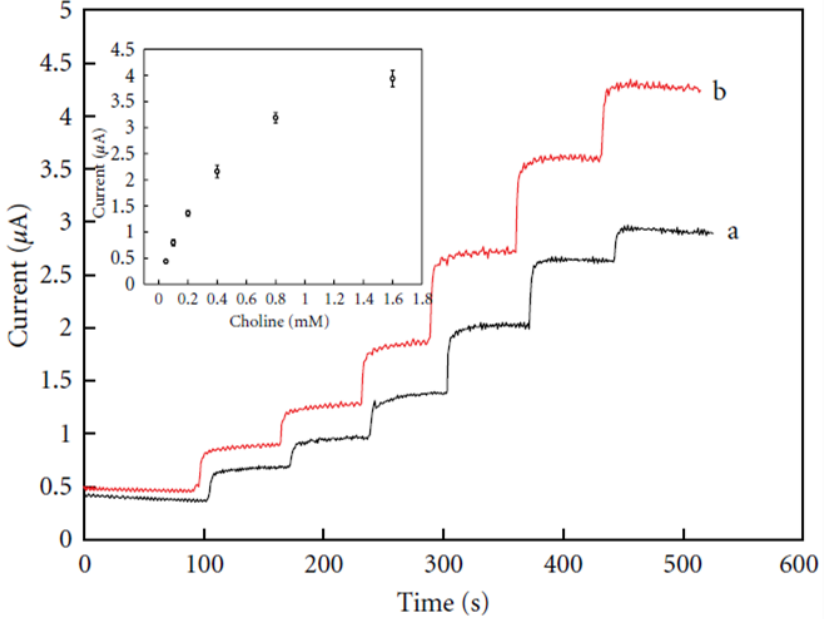
Figure 5. Current–time response of ( a ) AuNPs-Pt and ( b ) MWCNTs/AuNPs-Pt electrodes upon successive addition of choline; insert is calibration curve of the MWCNTs/AuNPs/Pt electrode. Reprinted with permission from [64]. Copyright (2016) Elsevier.